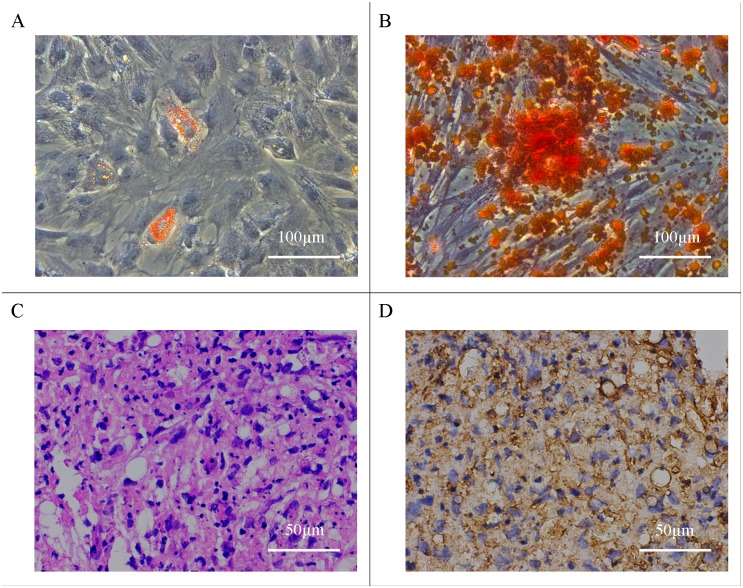
Multipotent differentiation of hASCs in vitro.(A) Oil Red O staining detected red-colored oil droplets in adipogenic differentiation of hASCs; (B) Alizarin Red detected calcium mineralization in osteogenic differentiation of hASCs; (C and D) For chondrogenic differentiation, histological and H&E staining results showed that cartilage lacunae were formed and expressed chondrocyte gene marker, collagen II.